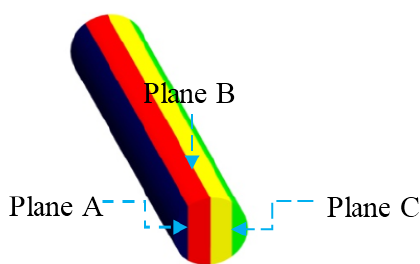
Figure 2. Plane sections taken through the processed ECAP billet in the simulation and experimental work.